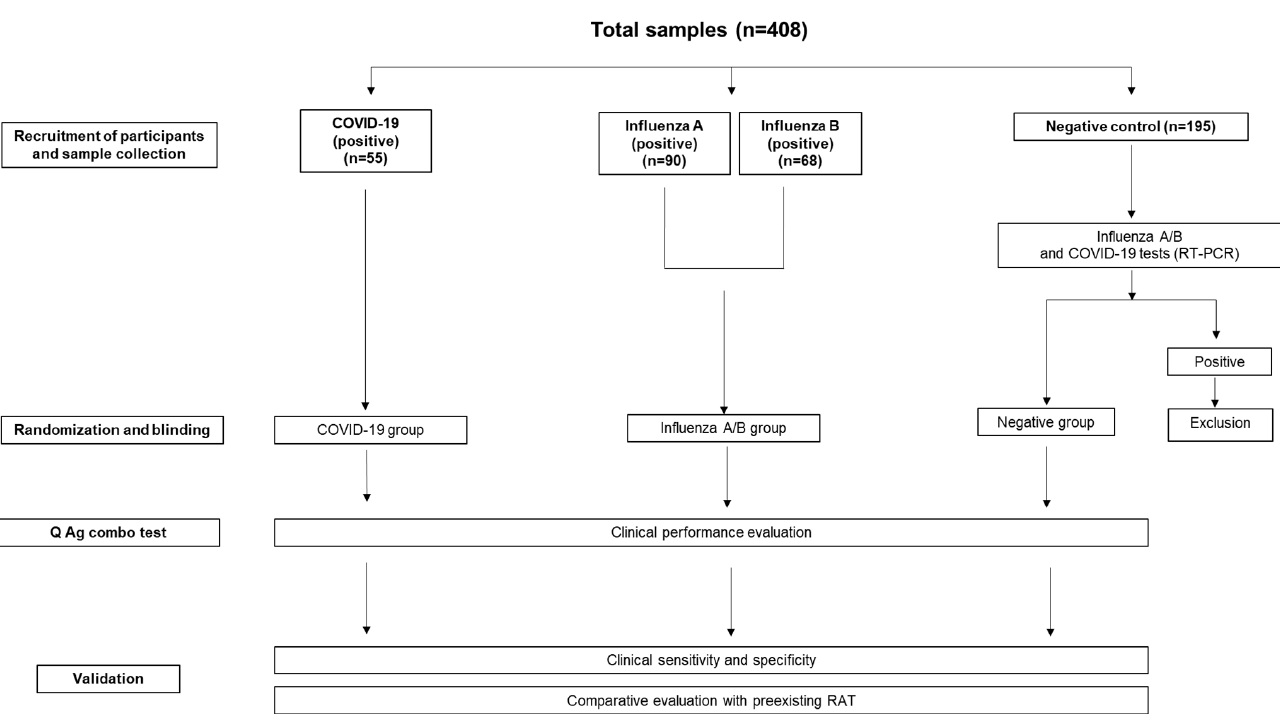
Figure 1. Diagram representing the study design. Following the sample collection, randomization, and blinding, the clinical performance evaluation of the Q Ag combo test was conducted. Subse- quently, the Q Ag combo test results were compared with the results from preexisting RAT and with RT-PCR results for validations.